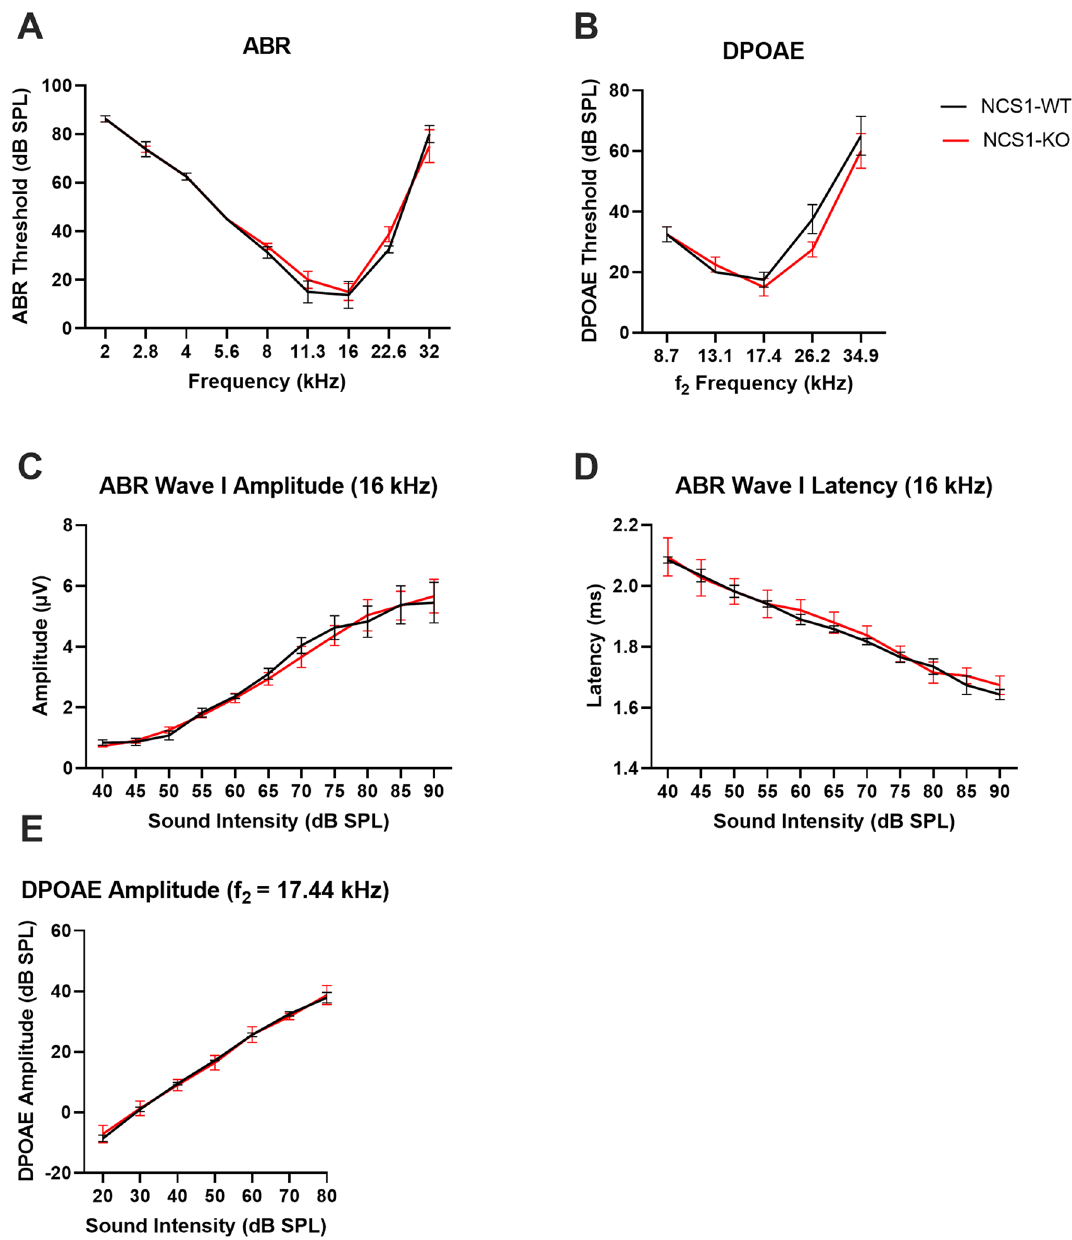
Figure 3. NCS1-WT and -KO mice exhibit similar hearing. ( A , B ) The graphs illustrated the average ABR ( A ) and DPOAE ( B ) thresholds of NCS1-KO and -WT mice as a function of stimulus frequency. There were no significant differences in both ABR (2-way ANOVA, Factor genotype, p = 0.67) and DPOAE (2-way ANOVA, Factor genotype, p = 0.22) thresholds between NCS1-KO and NCS1-WT mice across the frequency range tested. ( C , D ) The graphs illustrated the average amplitude ( C ) and latency ( D ) of ABR wave I as a function of sound intensity at 16 kHz. There were no significant differences in both amplitudes and latencies between NCS1-KO and NCS1-WT mice at all sound intensities. ( E ) The graph illustrated the average DPOAE amplitude as a function of sound intensity at the f 2 frequency of 17.44 kHz. There were no significant differences in DPOAE amplitudes at all sound intensities. Error bars are ± SEM. Male NCS1-WT: n = 2, male NCS1-KO: n = 2, female NCS1-WT: n = 2, female NCS1-KO: n =